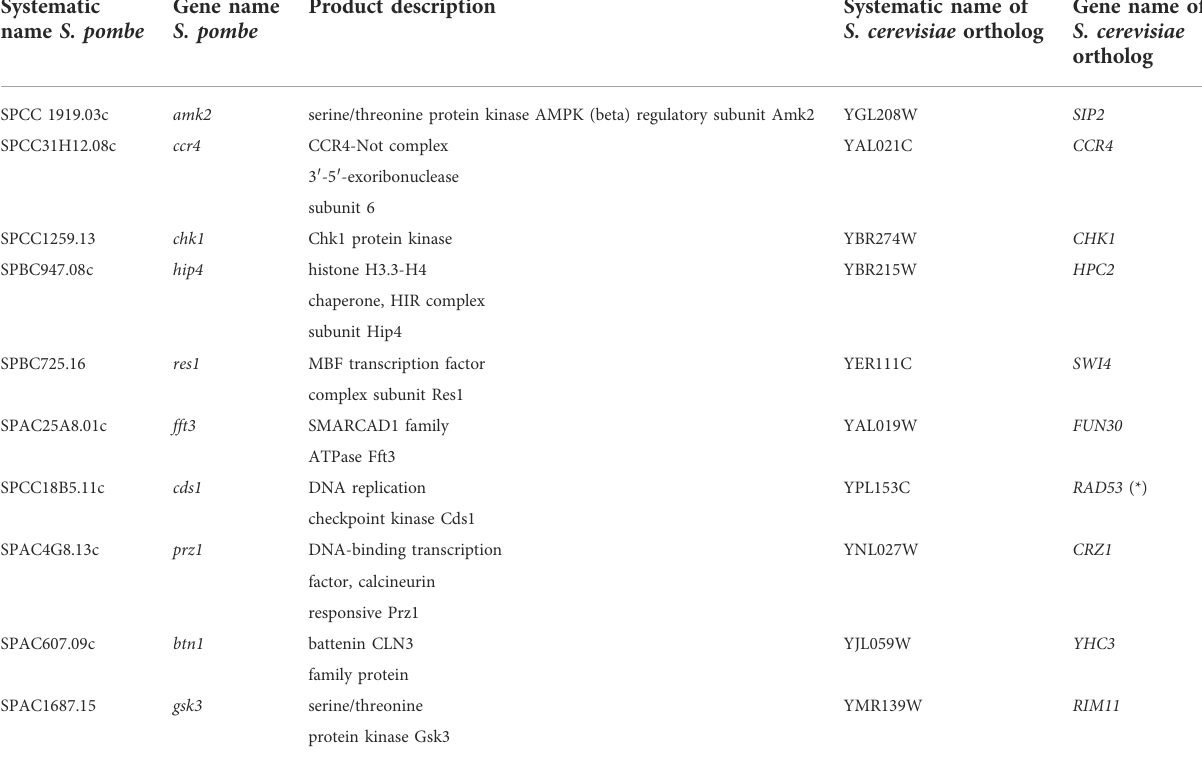
TABLE 5 The top-10 S. pombe TLM predicted genes and their S. cerevisiae orthologs. The rows are sorted in descending order by the model ’ s estimated probability of the prediction. Systematic name S.